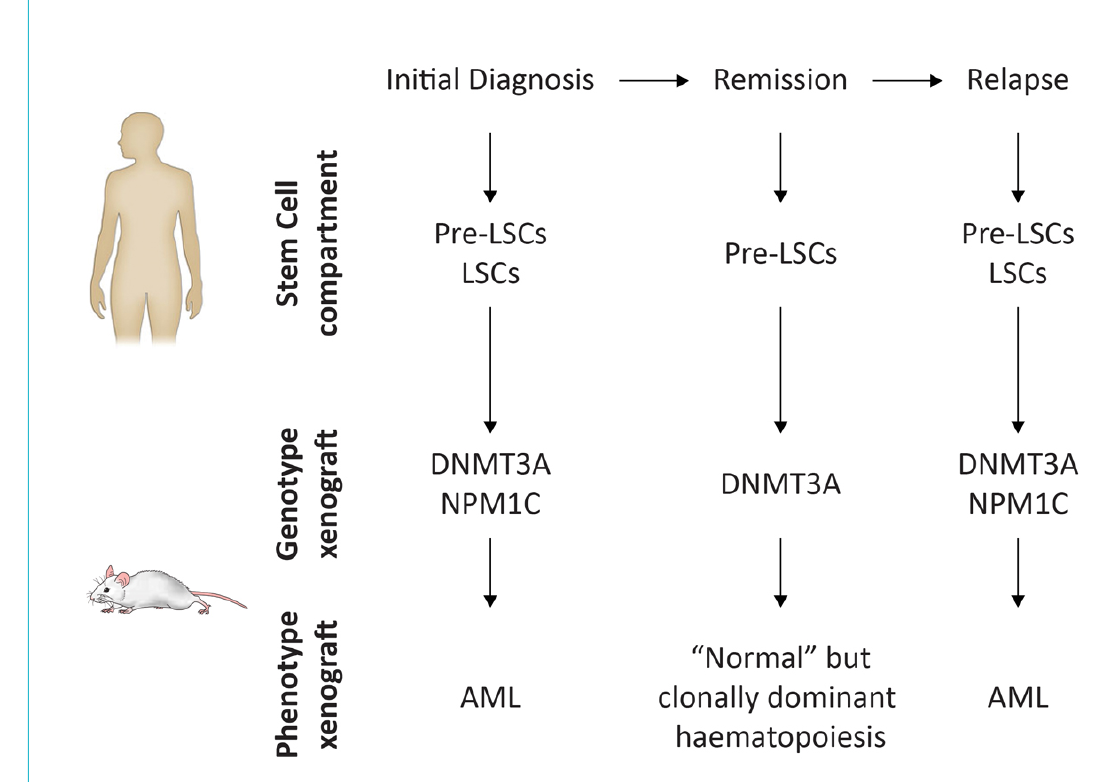
Figure 3: Concept of acute myeloid leukaemia (AML) xenograft models as an example for myeloid neoplasms. PDX models reflect phenotypic as well as genetic features of myeloid neoplasms. In AML, the HSC compartment consists of preleukaemic stem cells (pre-LSCs) and leukaemic stem cells (LSCs) that harbour somatic mutations. Transplantation of AML cells from the initial diagnosis into PDX models leads to AML development in vivo . Genetically aberrant pre-LSCs can persist in patient remission, but lead to multilineage (normal) repopula- tion in PDX models. Frequently, the persistence of pre-LSCs that acquire additional somatic mutations is at the origin of disease relapse, which can be reproduced in PDX models (adapted from